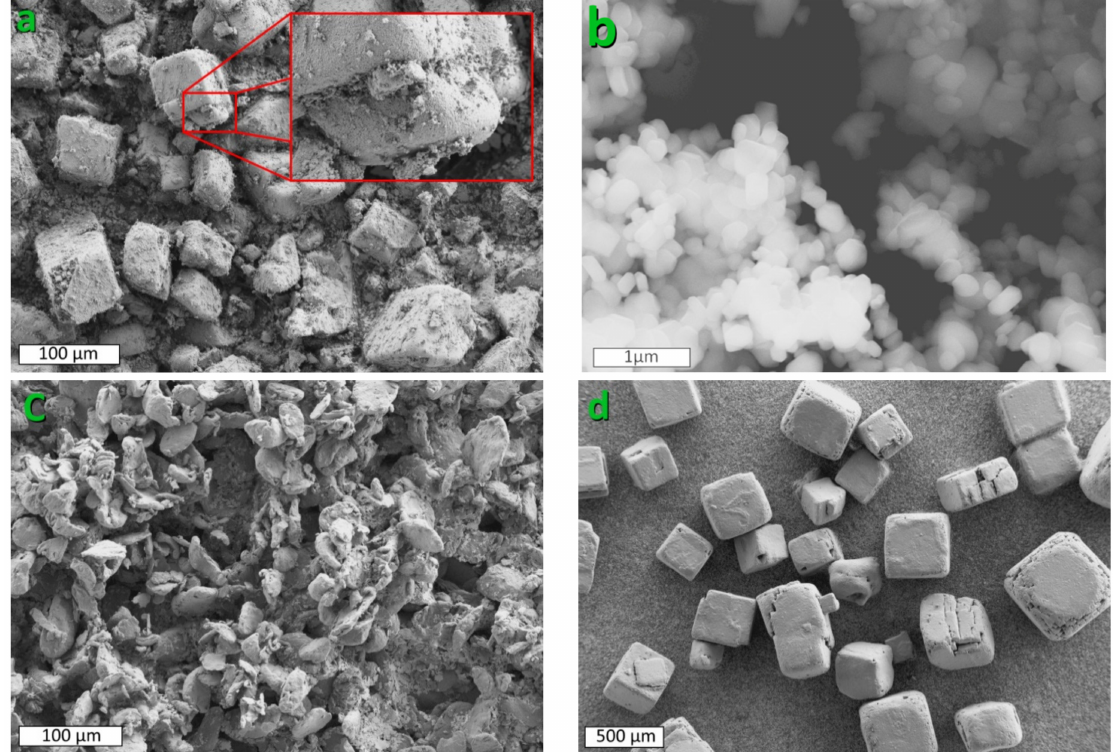
Figure 1. SEM observations of the reactants: ( a ) WO 3 ; ( b ) Cr 2 O 3 ; ( c ) Mg; ( d ) NaCl. Note that tungsten trioxide particles seem to be made of large grains covered with submicronic particles